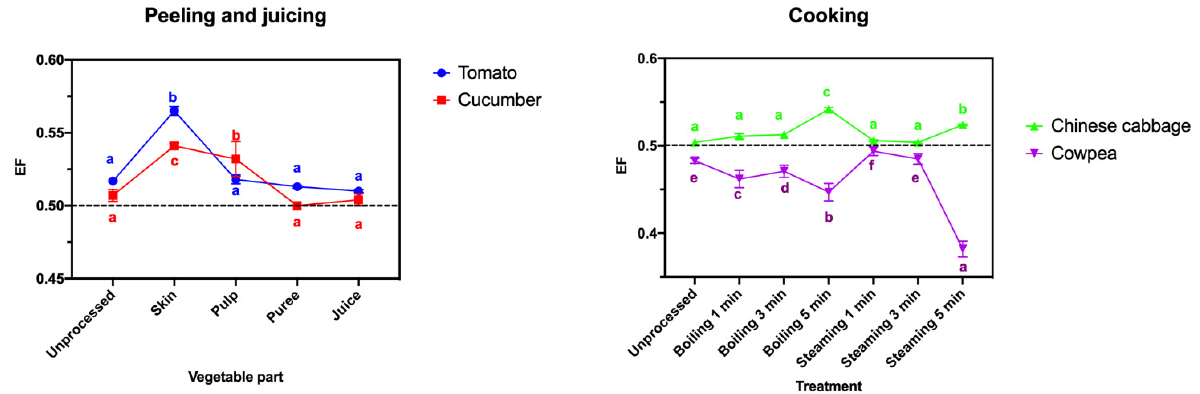
Figure 4. EF values of mandipropamid in four types of vegetable samples after different processing treatments. Each lowercase letter indicates significant differences between the different treatments ( p ≤ 0.05, Duncan’s multiple range test).